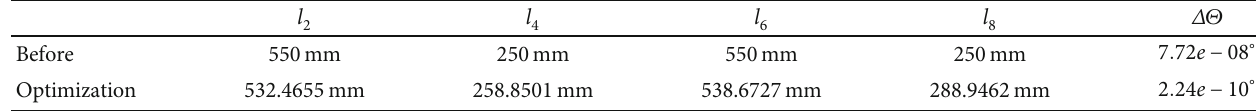
Table 1: Synchronous locking optimization results.